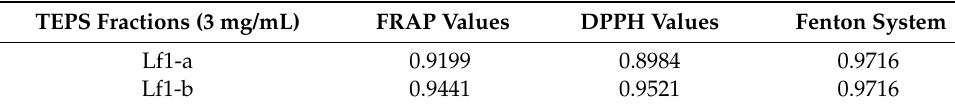
Table 6. Correlation of Lf1-a, Lf1-b, and antioxidant activity. TEPS Fractions (3 mg/mL) FRAP Values DPPH Values Fenton System Lf1-a